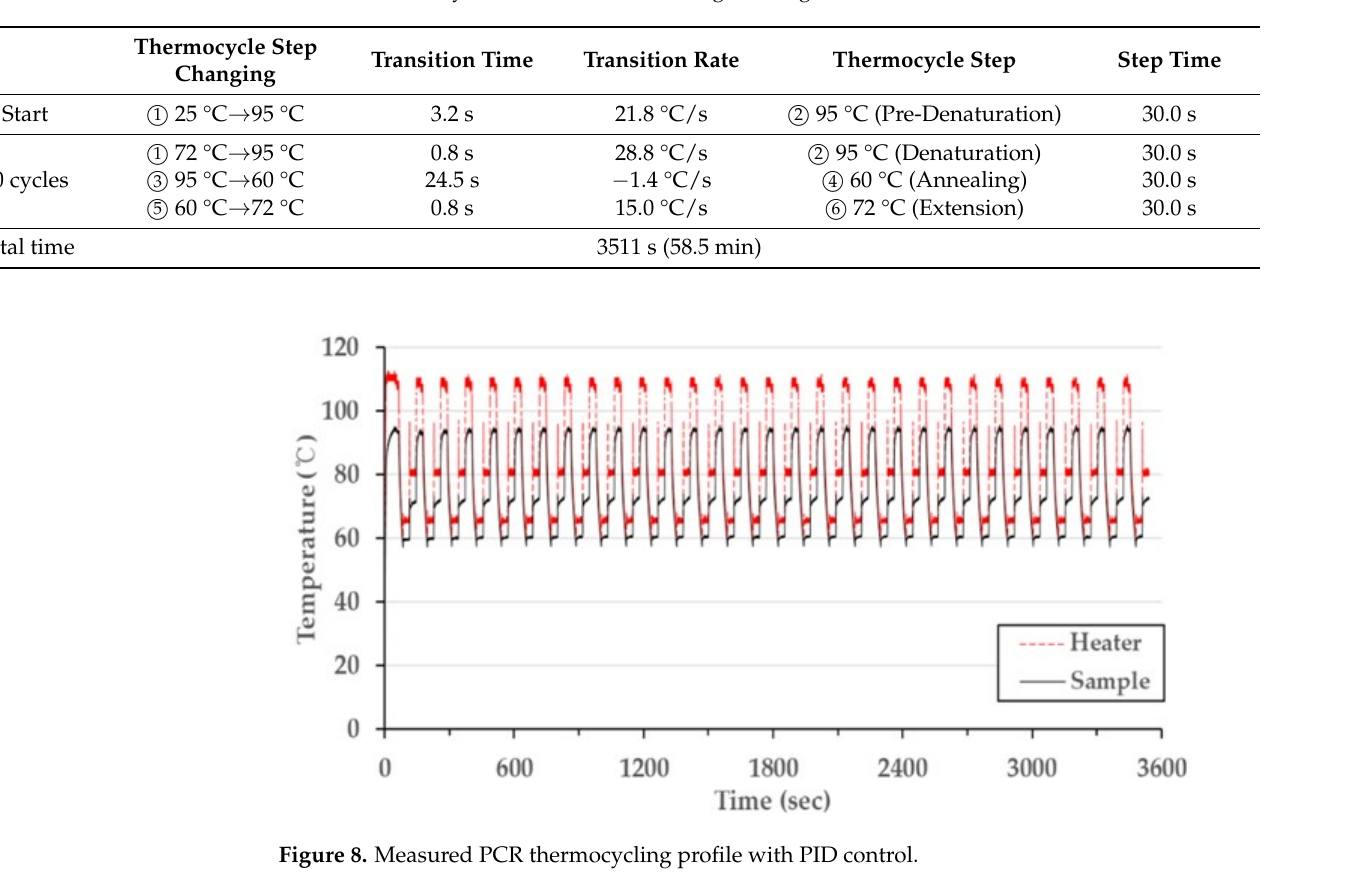
Table 3. Thermocycle conditions and heating/cooling rate.